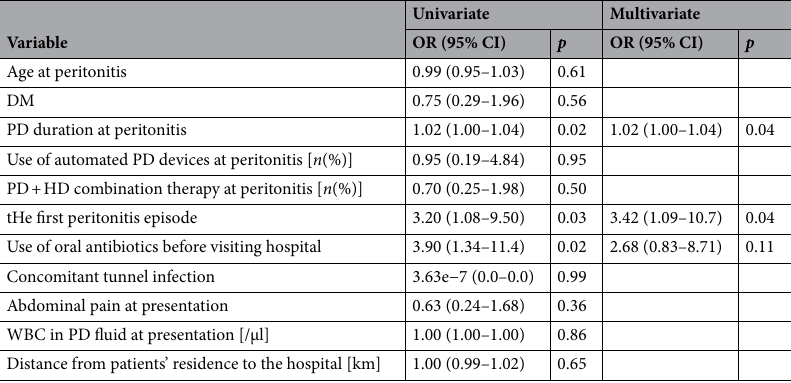
Table 4. Results of univariate and multivariate logistic regression analysis for ST time ≥ 24